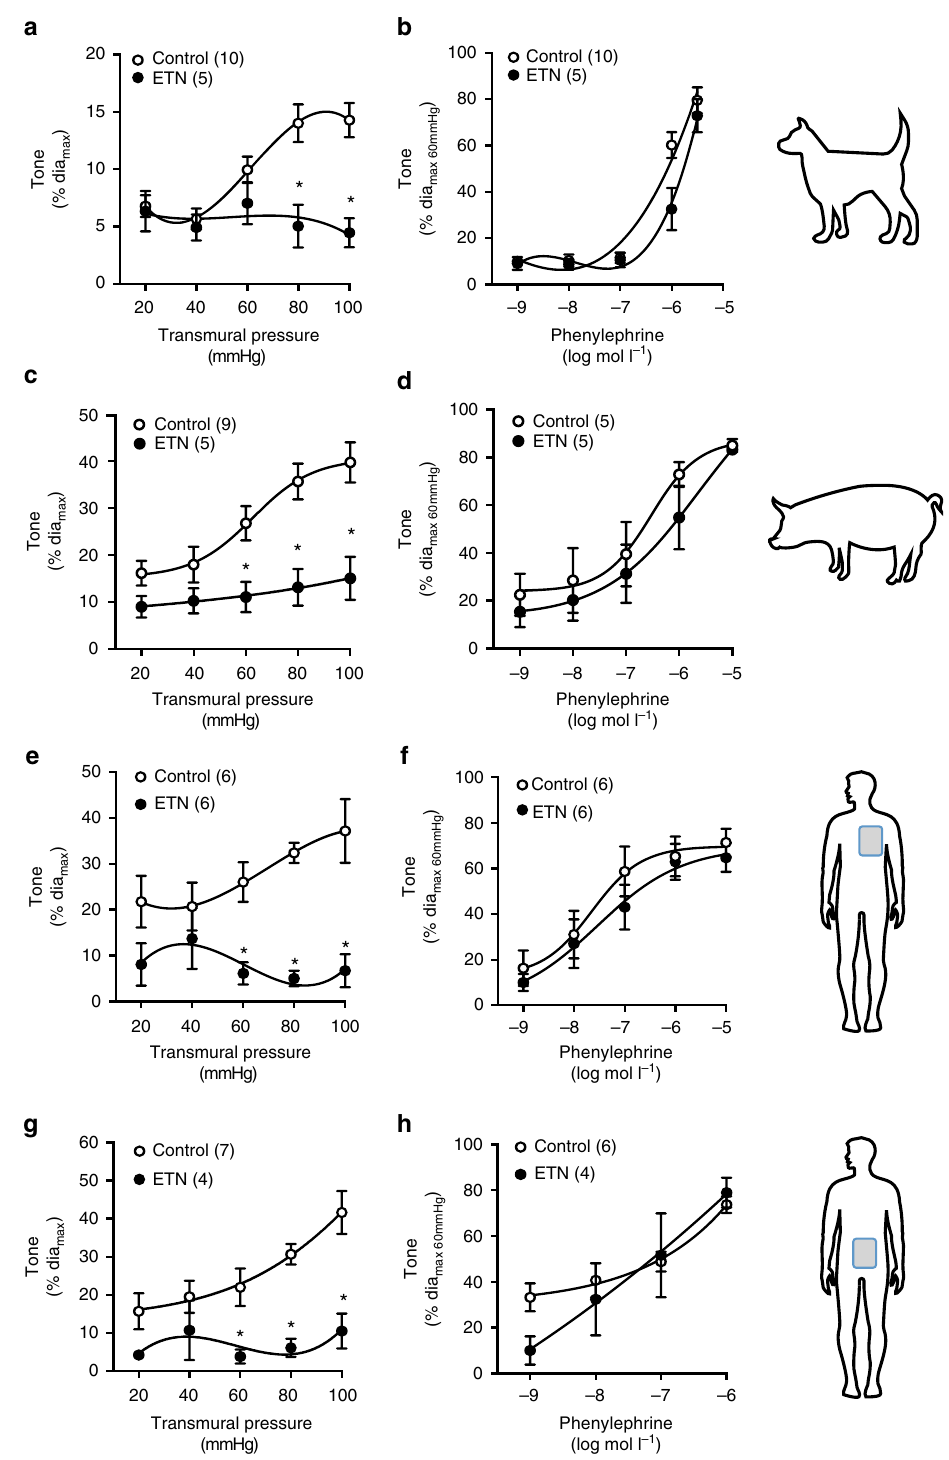
Figure 6 | TNF scavenging in skeletal muscle arteries from animals and humans. Myogenic and phenylephrine-stimulated vasoconstriction following treatment with etanercept (ETN, 300 m gml (cid:2) 1 in vitro ). ( a , b ) Dog gracilis skeletal muscle resistance arteries. ( c , d ) Pig gracilis skeletal muscle resistance arteries. ( e , f ) Human thoracic wall skeletal muscle resistance arteries. ( g , h ) Human lumbar skeletal muscle resistance arteries. Numbers in parentheses indicate arteries per group. All data are mean ± s.e.m. * P o 0.05 for unpaired Student’s t- test comparison at each pressure. Non-murine animal models . Female Golden Syrian hamsters (2–3 months of age; robust responses. Before functional assessment, arteries were washed in MOPS-buffered saline. Charles River Laboratories) were euthanized by isoflurane inhalation and cervical dislocation. Hamster gracilis arteries were rapidly dissected from surrounding skeletal muscle tissue, cannulated and cultured for 24h under constant flow con- ditions (1mlh (cid:2) 1 ) (ref. 29). This procedure permits hamster gracilis arteries to recover from the surgical removal of surrounding connective tissue and regain NATURE COMMUNICATIONS|8:14805|DOI: